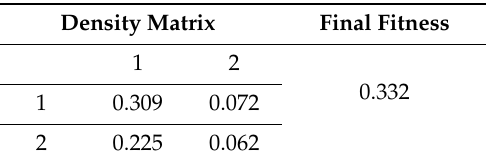
Table 4. Core-periphery value.